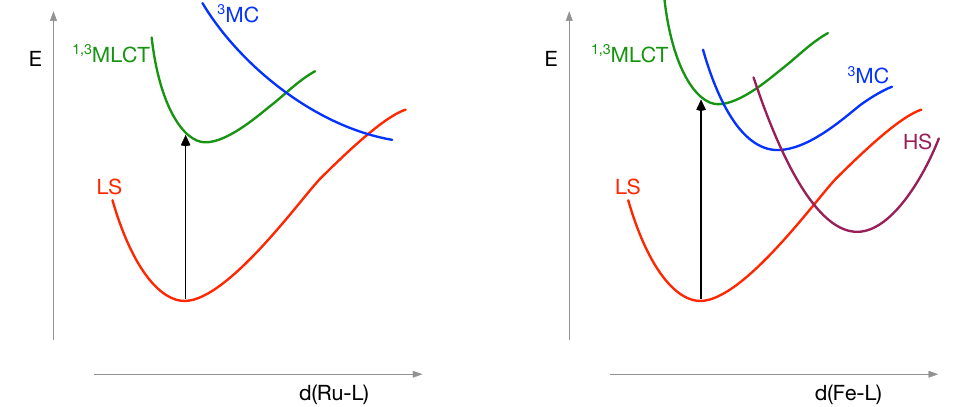
Figure 1. Schematic representation of the relative energies of the low-spin (LS), high-spin (HS), metal-to-ligand charge-transfer (MLCT) and excited metal-centered (MC) states as function of symmetric expansion of the first coordination sphere in Ru(II)- and